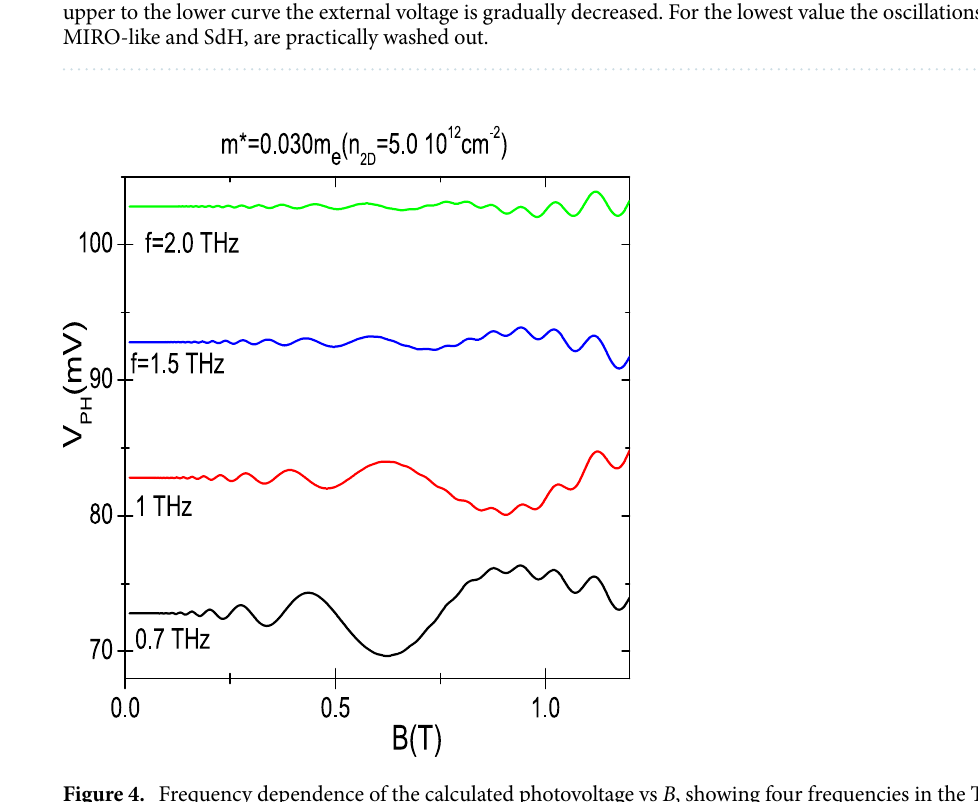
V 0 . The gate + 1 K . From the